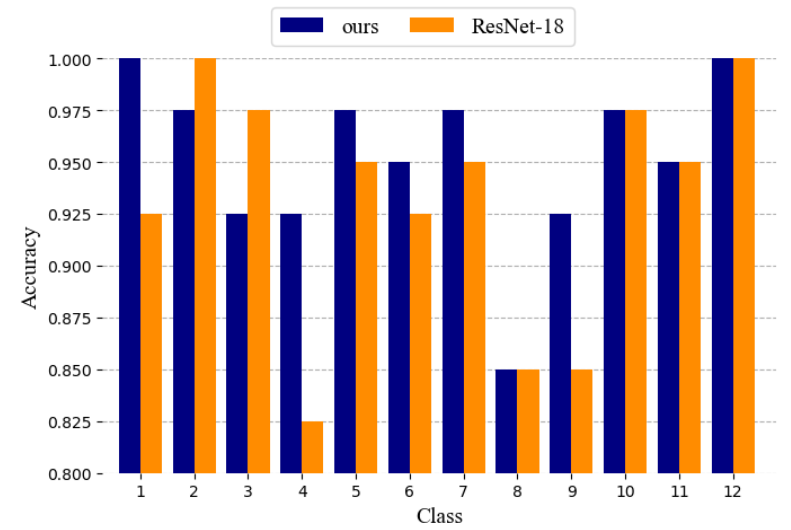
Figure 16. Accuracy in each class of ResNet-18 and our method for the Google dataset of SIRI-WHU.